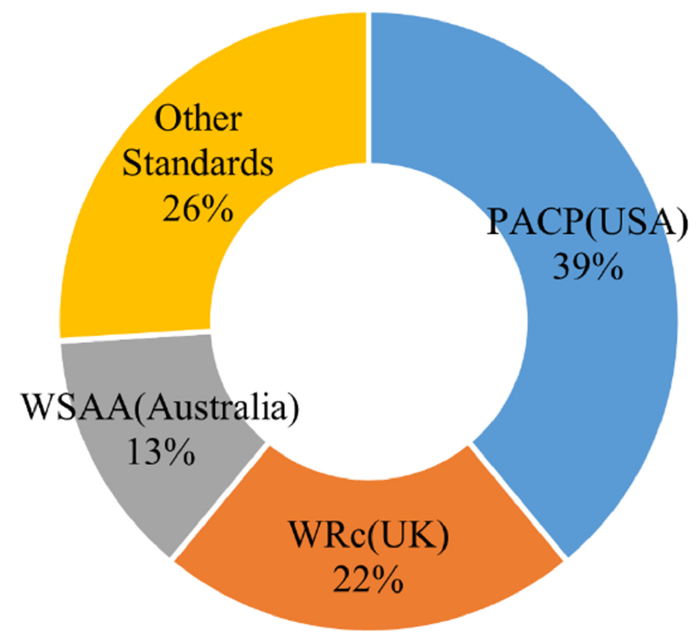
Figure 2. Common rating standards adopted during 2001–2019. Table 1. Classification and description of sewer pipe failure patterns.